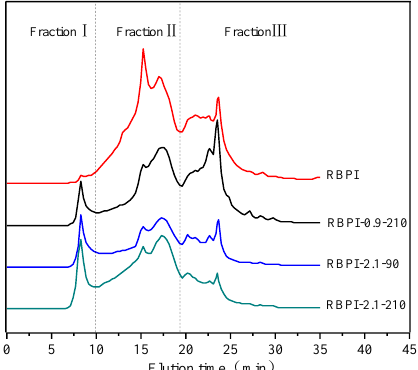
Figure 4. SEC profiles of RBPI prepared from different SFE pretreatment conditions.